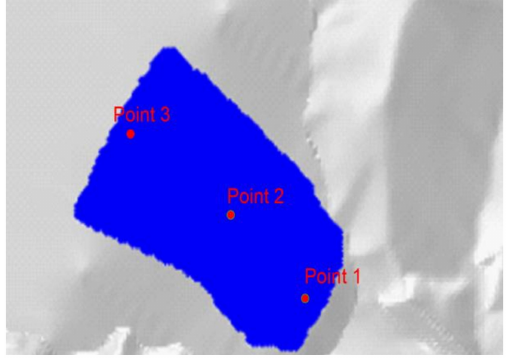
Figure 16. Location of measurement points.